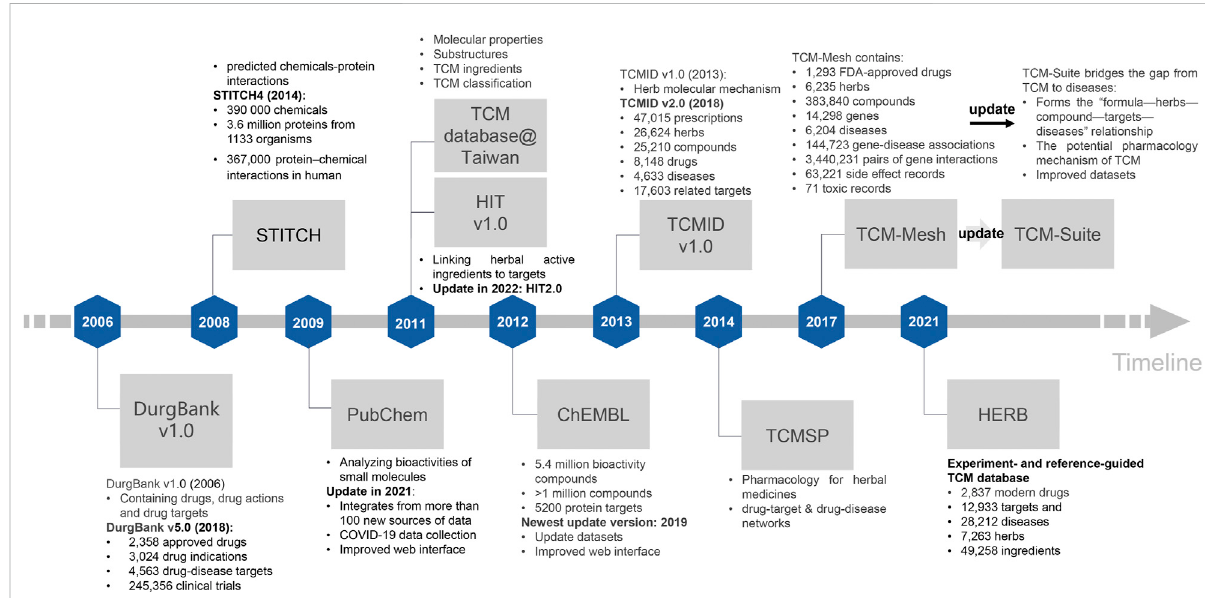
FIGURE 4 The development of commonly used TCM-disease databases along the timeline. We described the TCM databases based on their initial and most recent updated versions, respectively, which highlighted the primary composition, function, and characteristics of these databases along the timeline. The updated version of a database is highlighted in bold font of the